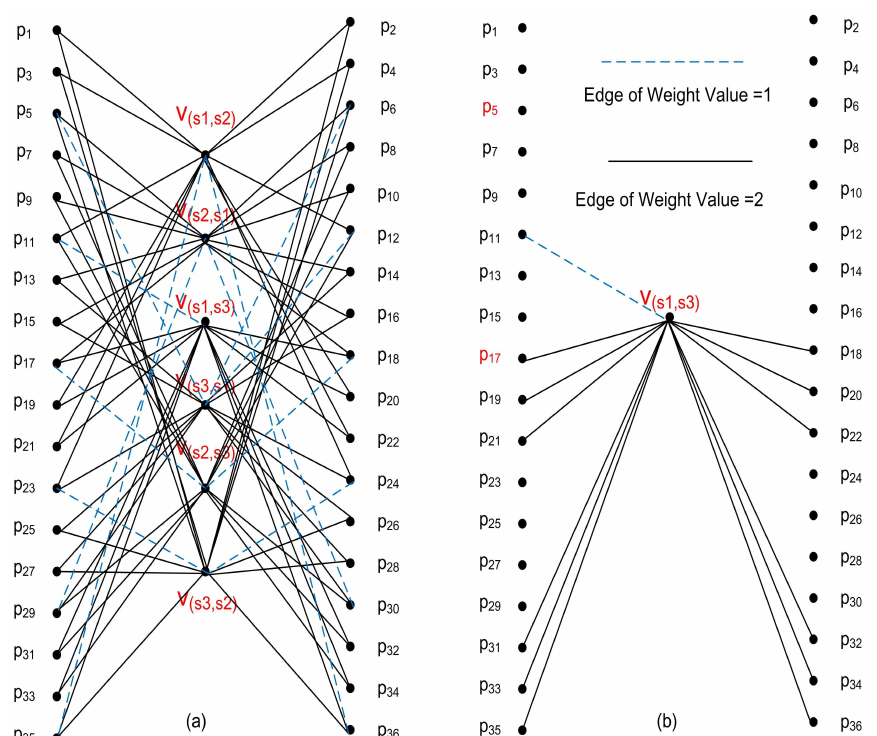
Figure 8. Example of the suggested WBG Algorithm with 3 SNs and GWs. ( a ) shows the complete bipartite graph, where α = 1 and β = 2. The weights of the edges joining P 11 and V s and V s are 1 and 2, respectively, as shown in ( b 1 , s 3